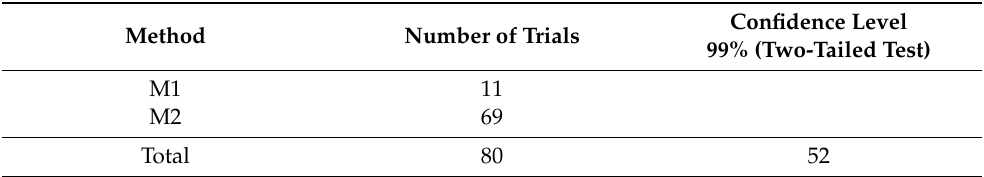
Table 2. Sensory evaluation. Preference